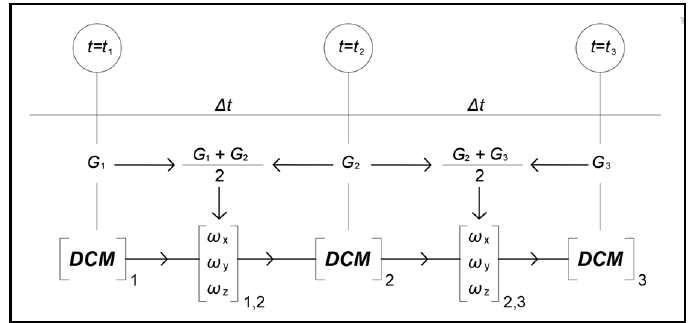
Figure 3. Angle calculation and update of rotation matrix by using output of gyroscopes.